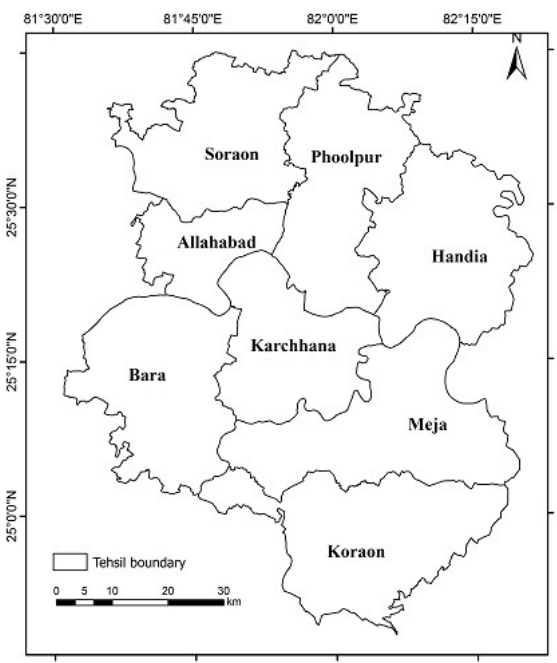
Figure 1. Study area map showing Allahabad district with tehsil boundary of all eight tehsils.